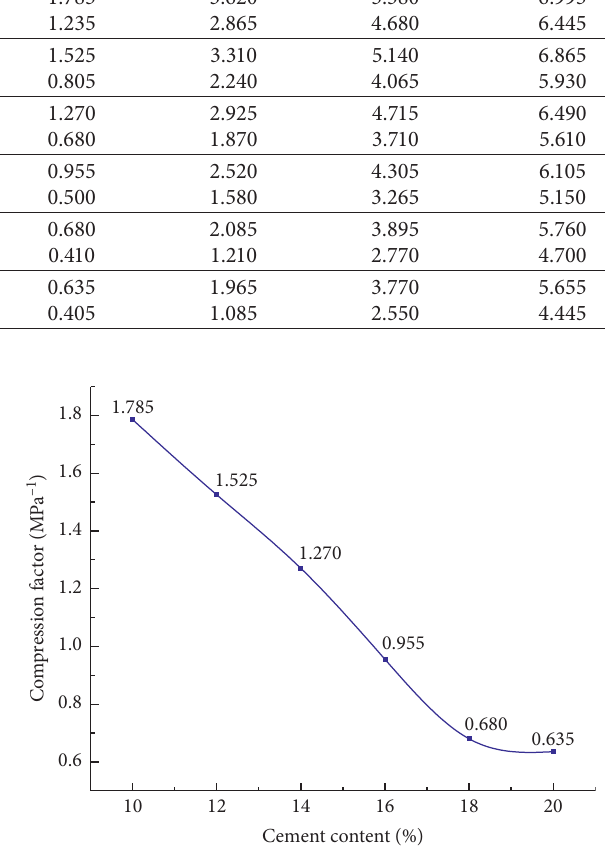
Figure 5: a 1-2 of CCS -7 with different cement